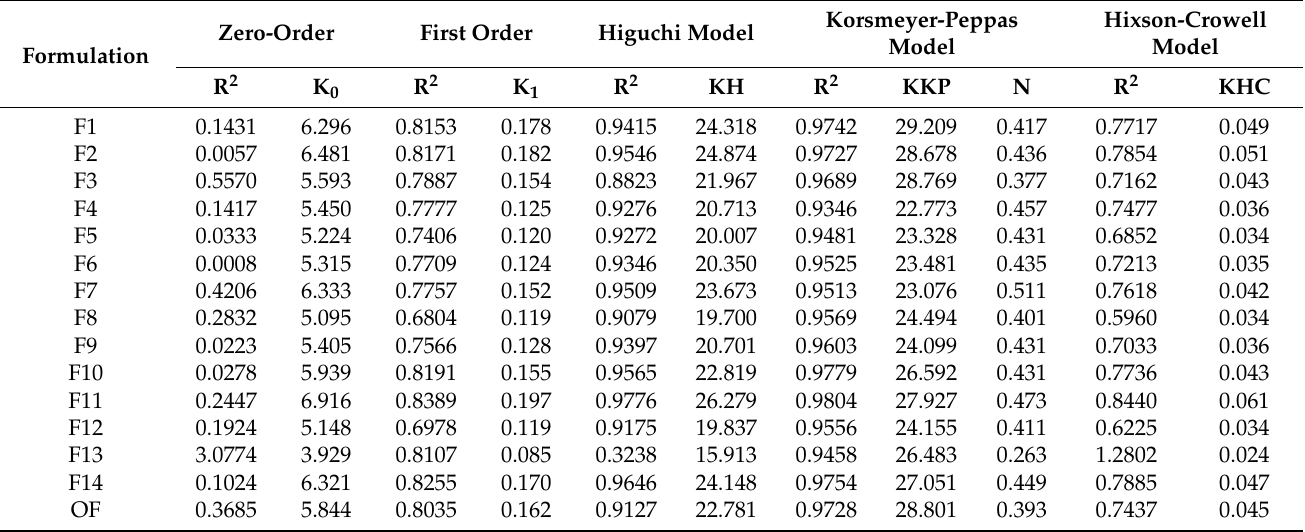
Table 3. R 2 and coefficient values of Kinetic models used for β -CD hydrogels.